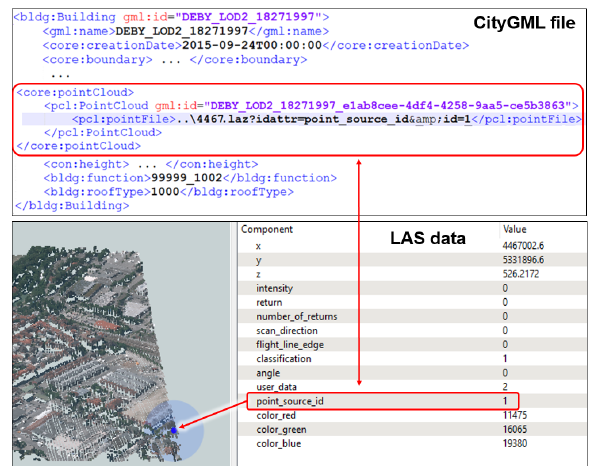
Figure 8. Example for linking points within a LAS file